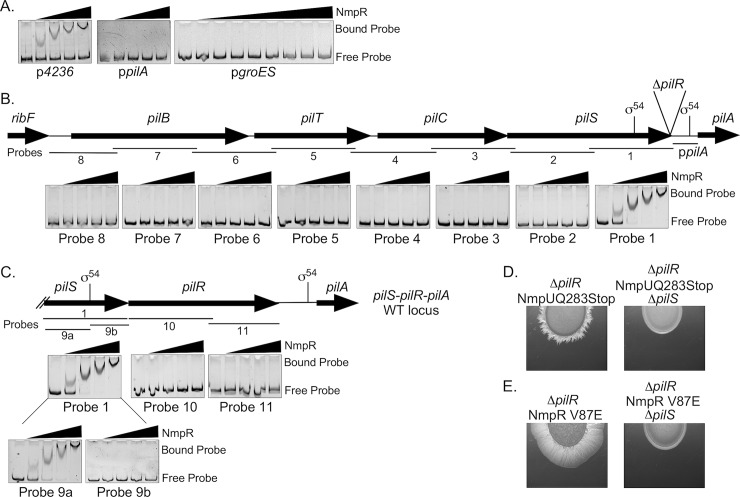
NmpR binds specific promoters upstream of its own putative operon and upstream of pilR.(A) NmpR binds to the promoter regions of mxan_4236 (referred to elsewhere as pNat—585 bp upstream of mxan_4236) (See also Fig 2A), but not to that of the pilA promoter (217 bp upstream of pilA) or pgroES (referred to elsewhere as pHigh—623 bp upstream of mxan_4894, groES). (B) NmpR binds specifically to a probe encompassing 800 bp upstream of pilR that includes a putative σ54 in the pilS open reading frame. The σ54 in the ppilA known to be utilized by PilR in a wild-type genomic context is also indicated. (C) Finally, NmpR binds only to a region within pilS upstream of the putative σ54 binding site. The sequence containing this NmpR-dependent promoter is necessary for the restored motility in the suppressor strains because deletion of pilS returned these strains to a non-motile phenotype (D and E). All shift assays depicted contained 200 fmol of DNA probe and increasing quantities of NmpR (0, 2, 8, 16, and 32 pmol, left to right). The exception is the pgroES shift that includes the same quantities of NmpR but with a broader range (0, 2, 4, 8, 12, 16, 20, 24, 32 pmol, left to right). All gene lengths and locations, as well as probe length and location are to scale.